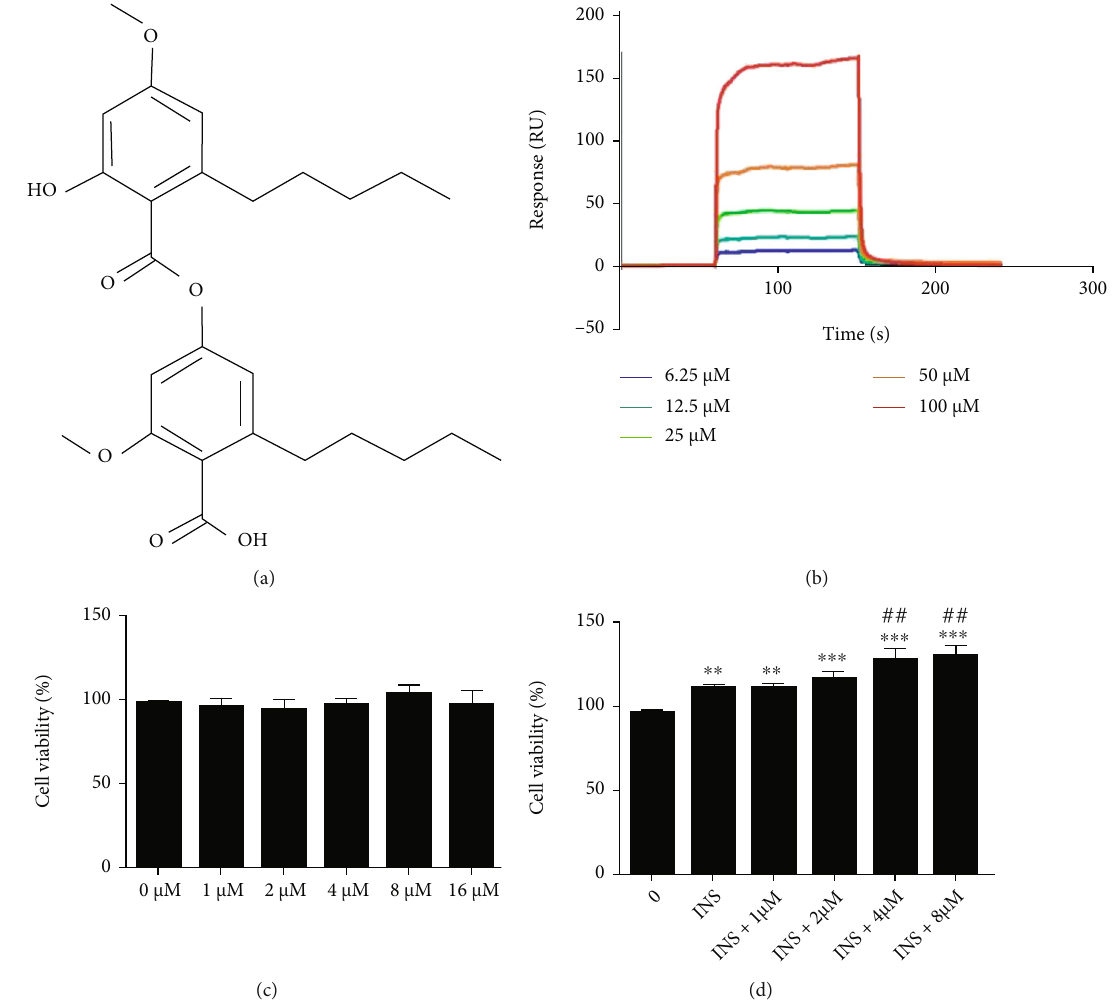
Figure 1: 2 ′ -O-Methylperlatolic acid (2-O-M) binds to the InsR. (a) Chemical structural of 2-O-M. (b) Binding a ffi nity of 2-O-M to InsR. (c) Cytotoxic e ff ects of 2-O-M on cells. The change in cell viability caused by 2-O-M in the presence of insulin. Data are shown as the mean ± SEM ( n = 6/7 in each group). ∗ p < 0 : 05 ; ∗∗ p < 0 : 01 ; ∗∗∗ p < 0 : 001 versus control. # p < 0 : 05 ; ## p < 0 : 01 ; ### p < 0 : 001 versus